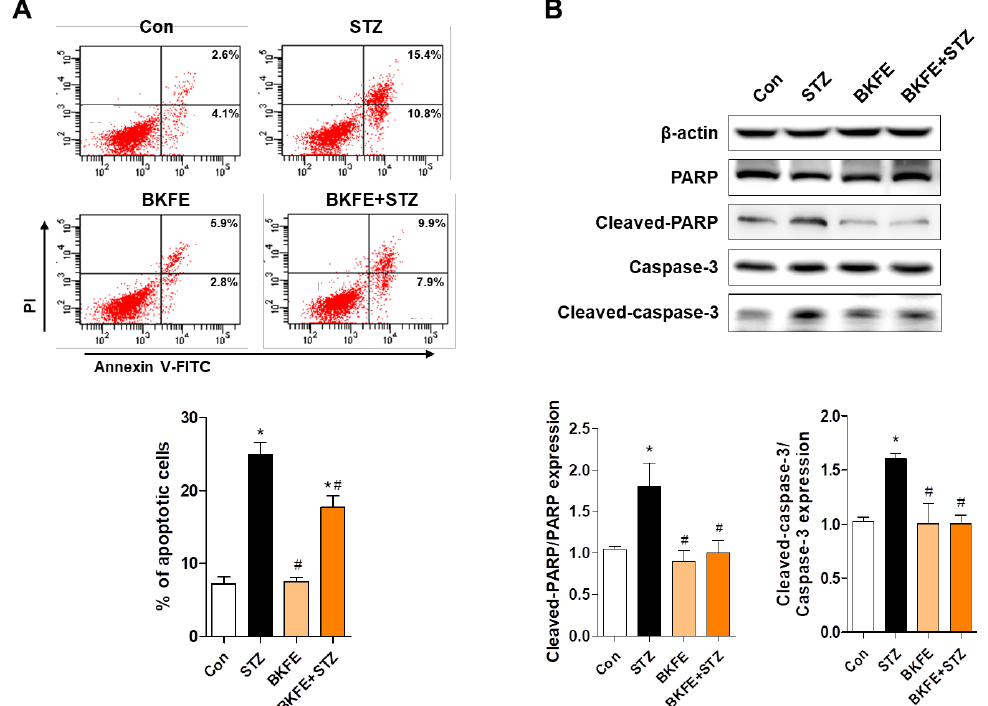
Figure 5. BKFE inhibits STZ-induced apoptosis in MIN6 cells. Cells were treated as described in Figure 4C, and ( A ) apoptotic cells were labeled using annexin V-FITC / PI and detected with flow cytometry. Percentage on representative dot plots indicates the early (the lower right quadrant) and late (the upper right quadrant) apoptotic cells. Graph shows quantitative data for the percentage of the sum of early and late apoptotic cells. ( B ) Expression levels of cleaved-PARP and cleaved-caspase-3 were detected by Western blotting. Densitometry quantification of the relative expression of proteins was performed using the ImageJ software. Data are presented as mean ± SEM from three independent experiments. * p < 0.05 vs. Con; # p < 0.05 vs. STZ; Con, Vehicle + citrate bu ff er; STZ, Vehicle + STZ; BKFE, BKFE + citrate bu ff er; BKFE + STZ, BKFE +